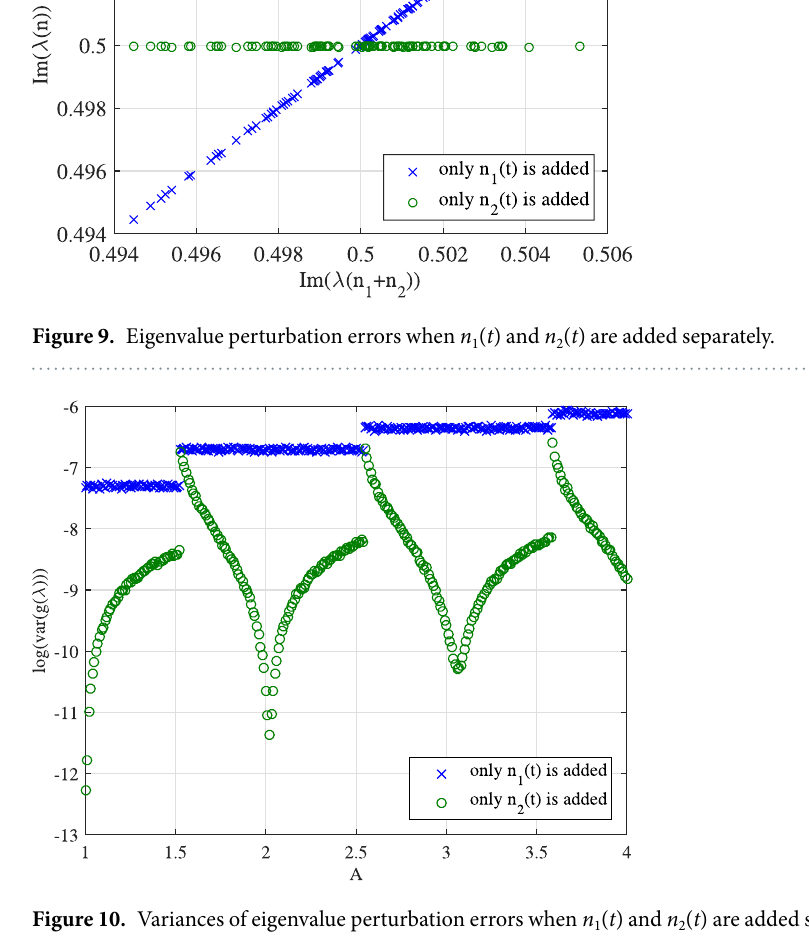
Figure 10. Variances of eigenvalue perturbation errors when n 1 ( t ) and n 2 ( t ) are added